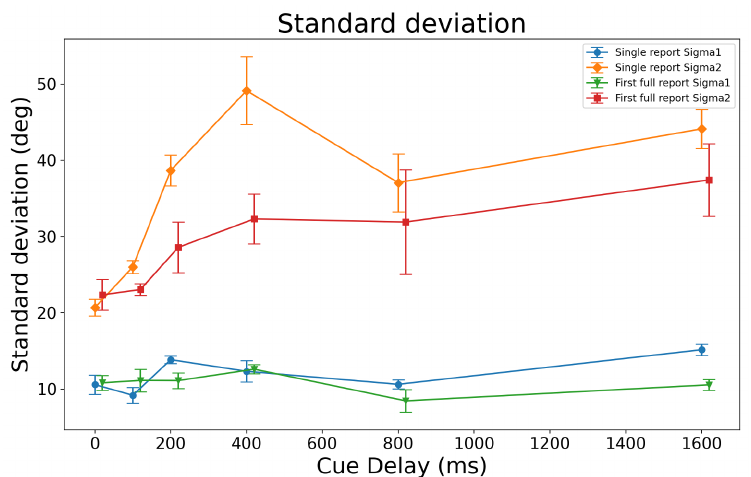
Figure 9. Standard deviations averaged across observers as a function of the cue delay. Error bars represent ±SEM. Of the two standard deviation parameters, the one with the smaller value is independent of the cue delay in both the single report and first full report conditions. For the standard deviation with the larger value, its dependence on the cue delay did not reach significance for the FR1 condition, whereas it did for the SR